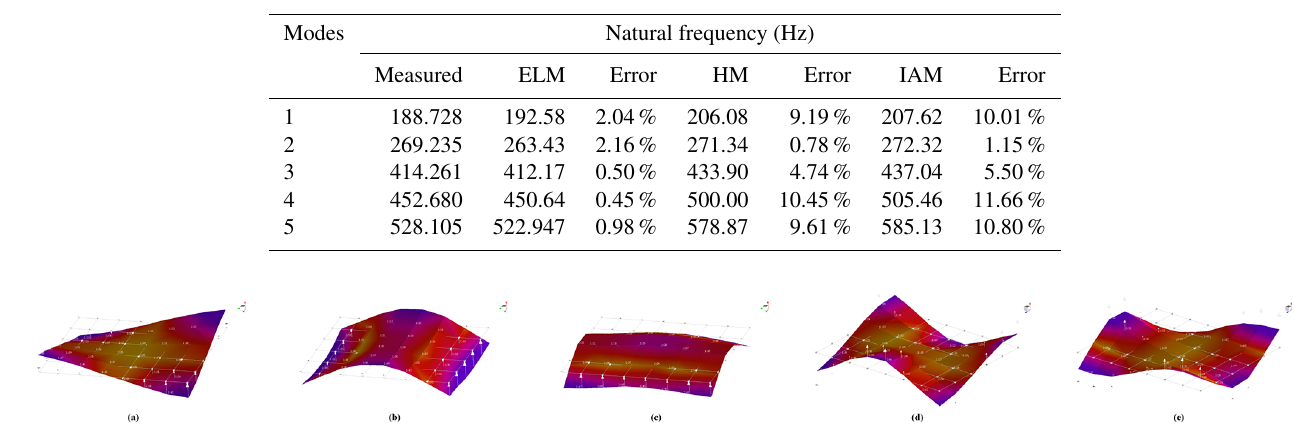
Table 11. Comparison of the first five natural frequencies between test results and simulation results.